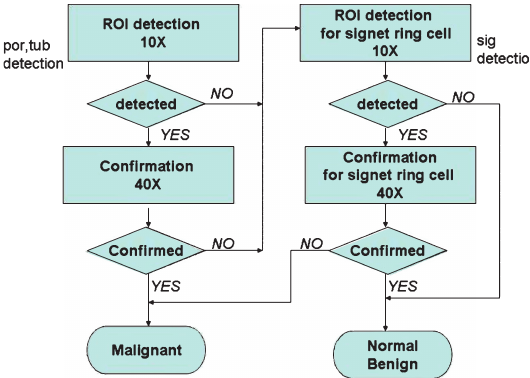
Fig. 1 Construction of the